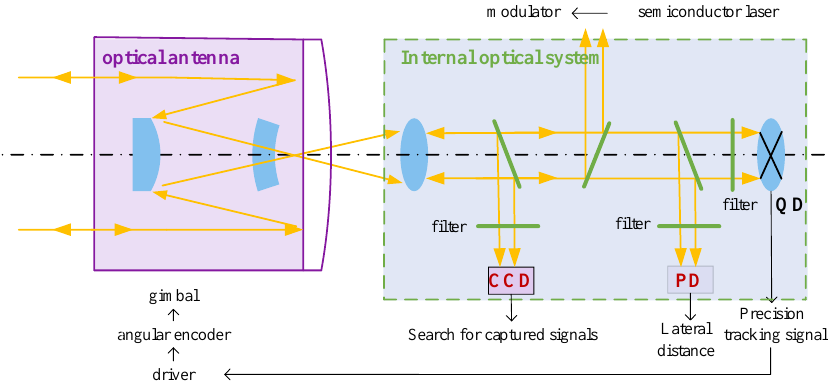
Figure 17. The spaceborne LiDAR system.